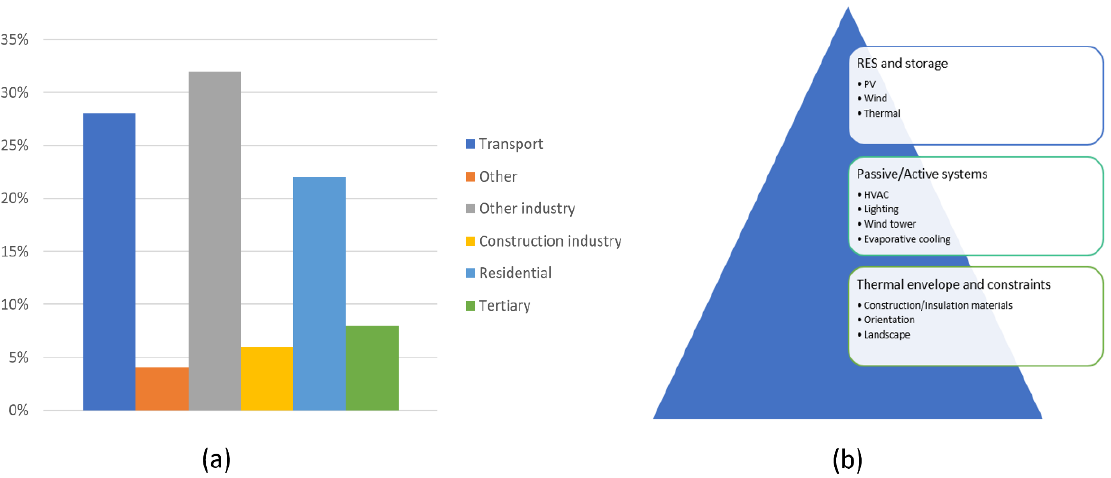
Figure 1. Presentation of the building: ( a ) its worldwide consumption among other sectors ( b ) as a complex structure.